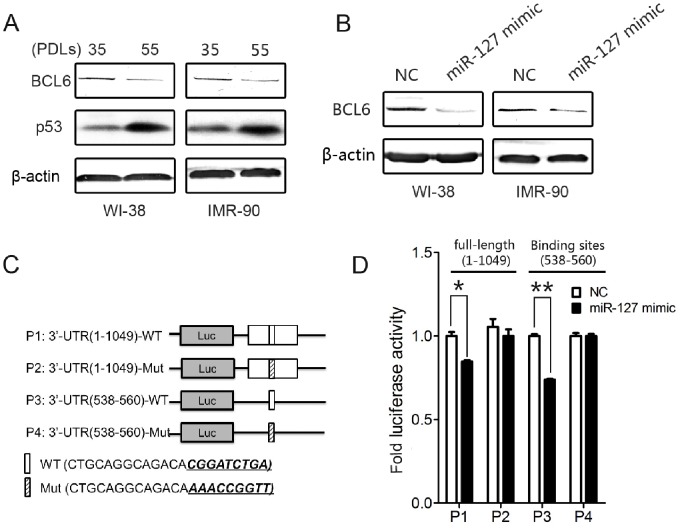
BCL6 is a direct target of miR-127.(A) Expression levels of BCL6 in different PDLs of WI-38 and IMR-90 cells. β-actin was used for normalization. (B) Representative Western blot analysis of BCL6 in WI-38 and IMR-90 cells transfected with 50 nM miR-127 mimic or negative control at 72 hours post-transfection. (C) Schematic representation of the luciferase reporter constructs containing full-length BCL6 3′-UTR (P1 contains wild-type miR-127 target sites and P2 is mutated in the miR-127 target sites) or the wild-type (P3) or mutant (P4) miR-127 target sites of BCL6 3′-UTR. (D) Luciferase reporter constructs (P1, P2, P3, and P4) along with pCMV-β-gal plasmid were cotransfected with miR-127 or negative control vector into MCF7 cells. Luciferase reporter assays were performed at 48 hours post-transfection. Data are presented as the mean ± SD from three independent experiments (*P<0.05, **P<0.01).